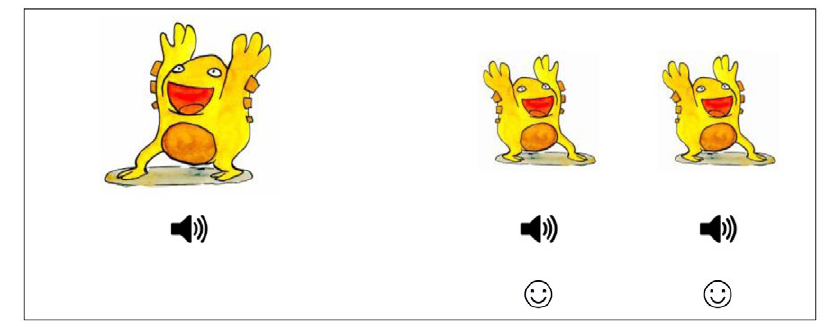
Figure 1: Sample item.